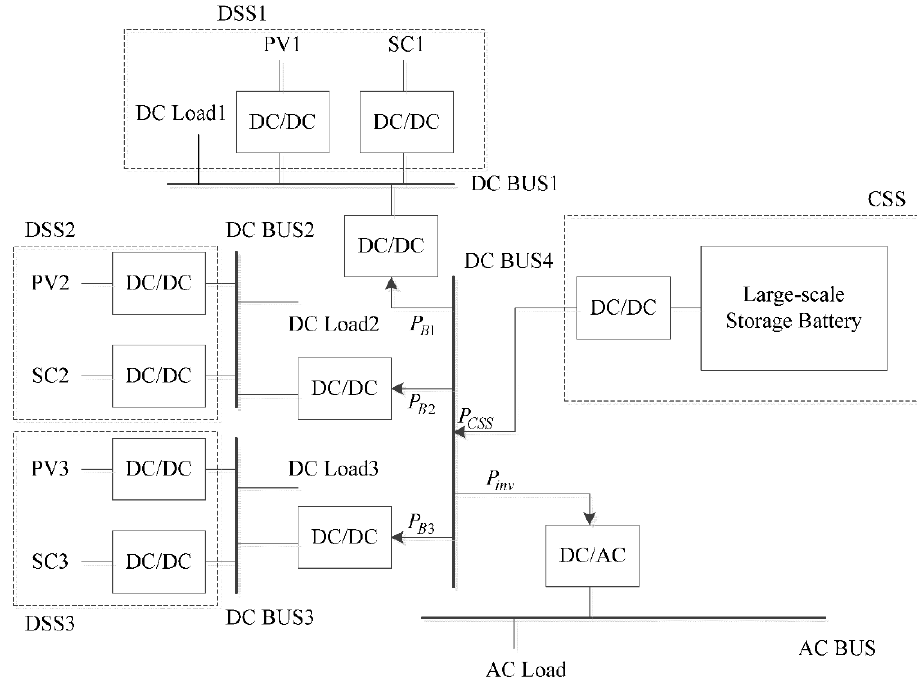
Figure 7. Control structure of a multiple distributed storage system with centralized storage system.